Question: Briefly state, in one sentence, what is plotted here.
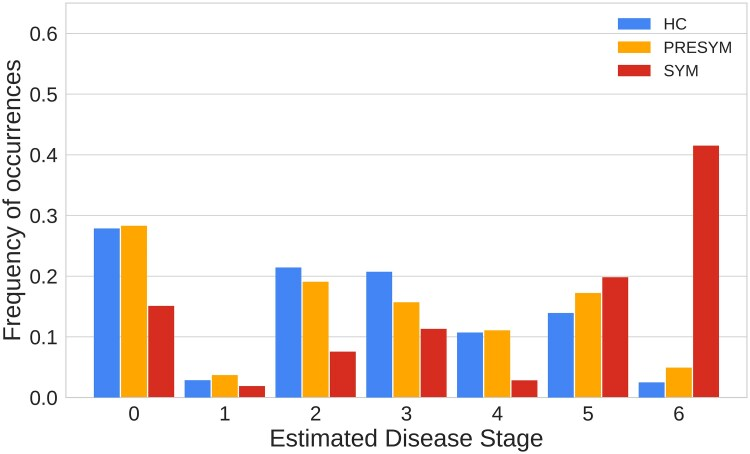
Answer: Subjects’ disease stage based on the sequencing obtained with discriminative event-based model (DEBM). Staging of subjects from all diagnostic categories (HC = healthy controls; Presym = presymptomatic subjects, Sym = FTD patients) are reported. Participants were assigned a disease stage based on the Discriminative Event-Based Model (DEBM) ( N = 711). Histograms are normalized for each diagnostic category (group numerosity: HC = [stage0: 78, stage1: 8, stage2: 60, stage3: 58, stage4: 30, stage5: 39, stage6: 7]; Presym = [stage0: 92, stage1: 12, stage2: 62, stage3: 51, stage4: 36, stage5: 56, stage6: 16]; Sym = [stage0: 16, stage1: 2, stage2: 8, stage3: 12, stage4: 3, stage5: 21, stage6: 44]).